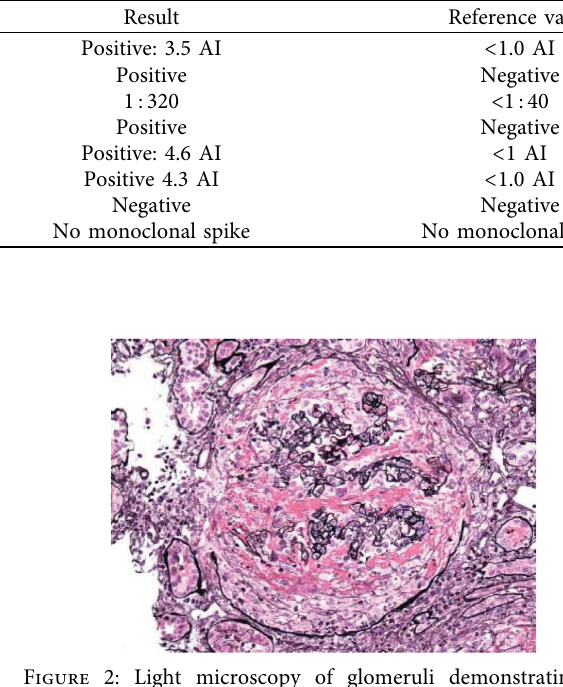
Table 2: Results of autoimmune workup.